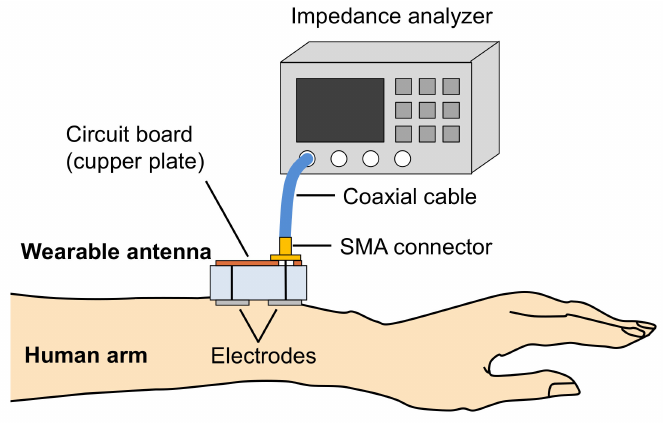
Figure 6. System for measuring wearable antenna.